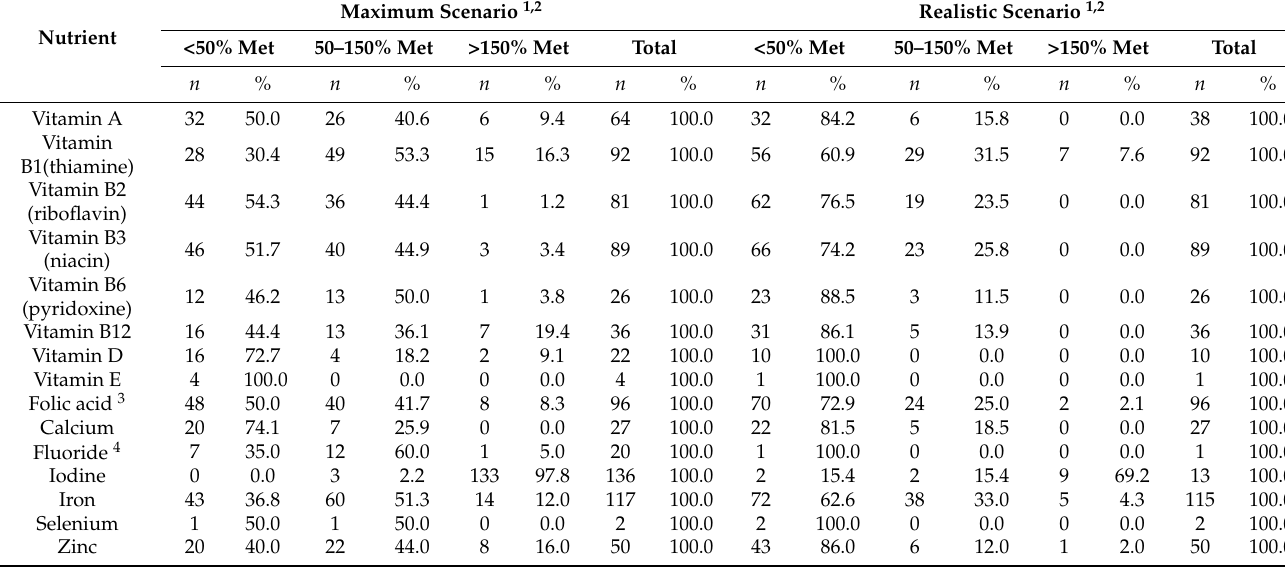
Table 3. The number of countries where the potential nutrient contribution under maximum and realistic scenarios was less than 50%, between 50 and 150% or greater than 150% of the Estimated of Average Requirement (EAR) met, when the nutrients in fortification requirements for maize flour, oil, rice, salt, and wheat flour are combined.